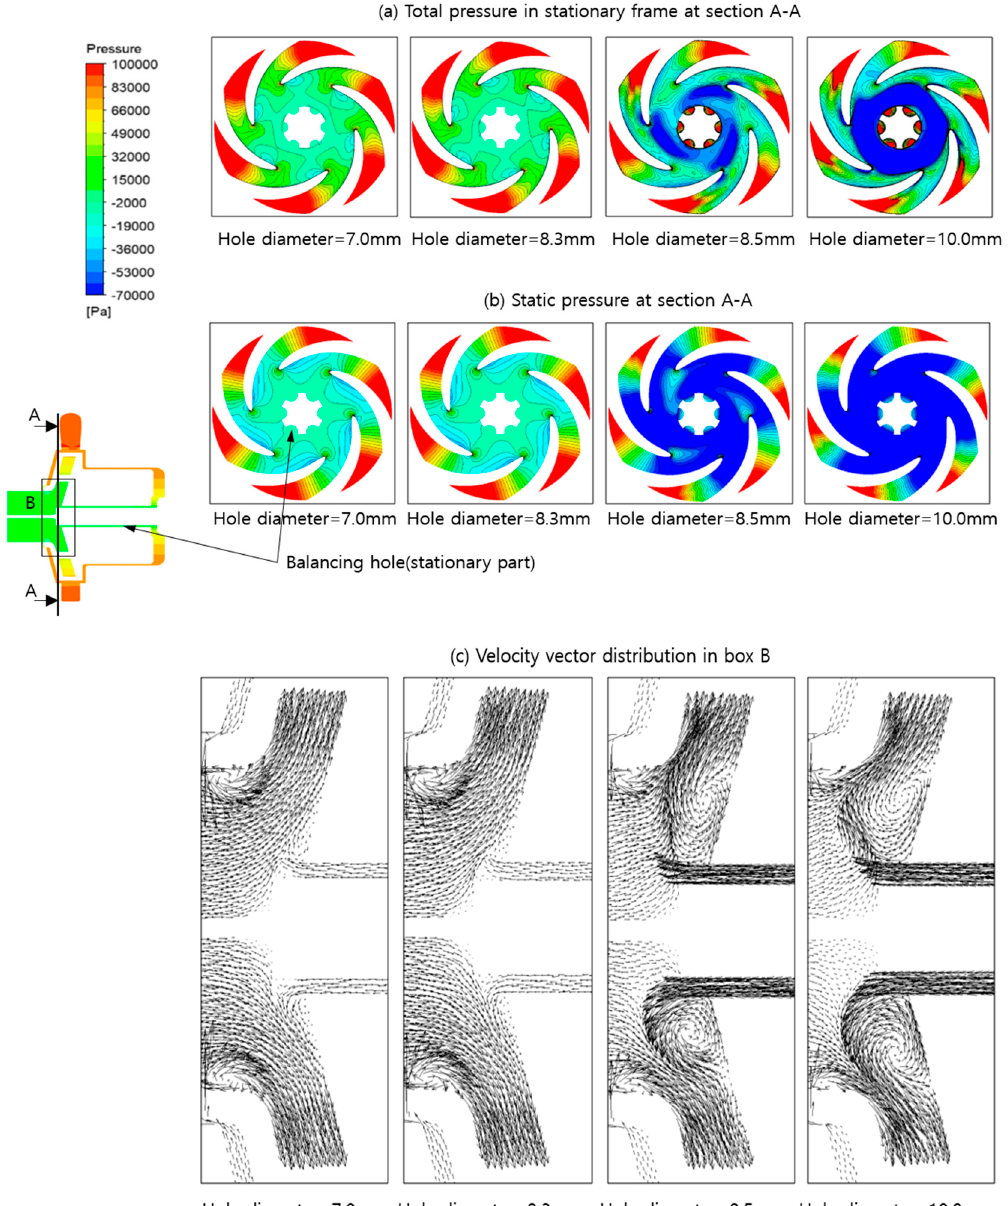
Figure 14. ( a ) Total pressure contours, ( b ) pressure contours, and ( c ) velocity vector distribution